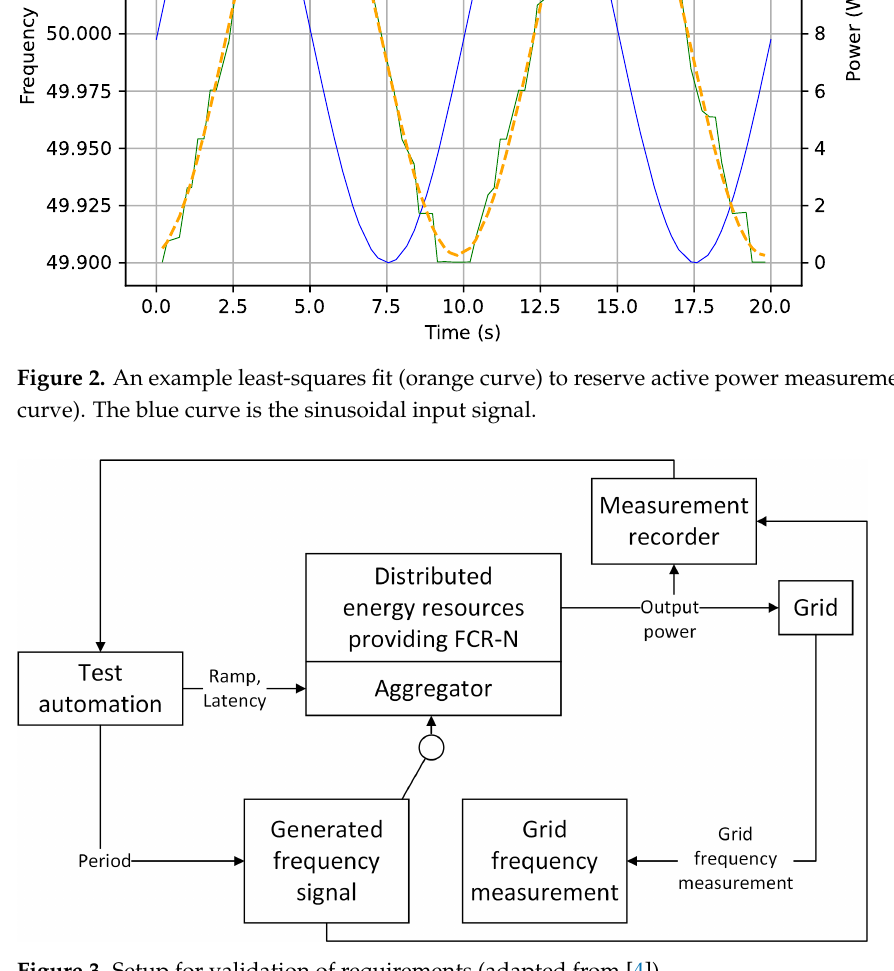
Figure 3. Setup for validation of requirements (adapted from